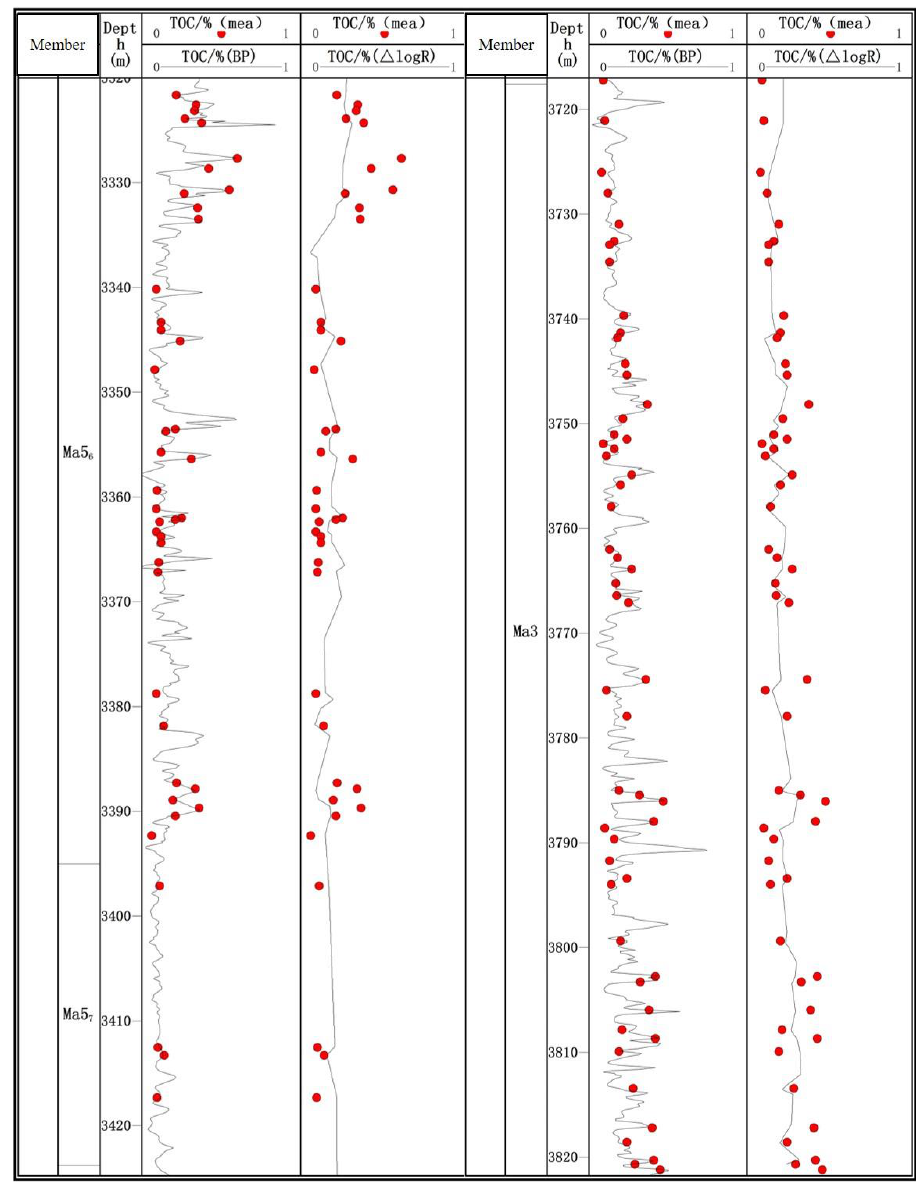
Figure 11. TOC calculation results of different models in well LT1.